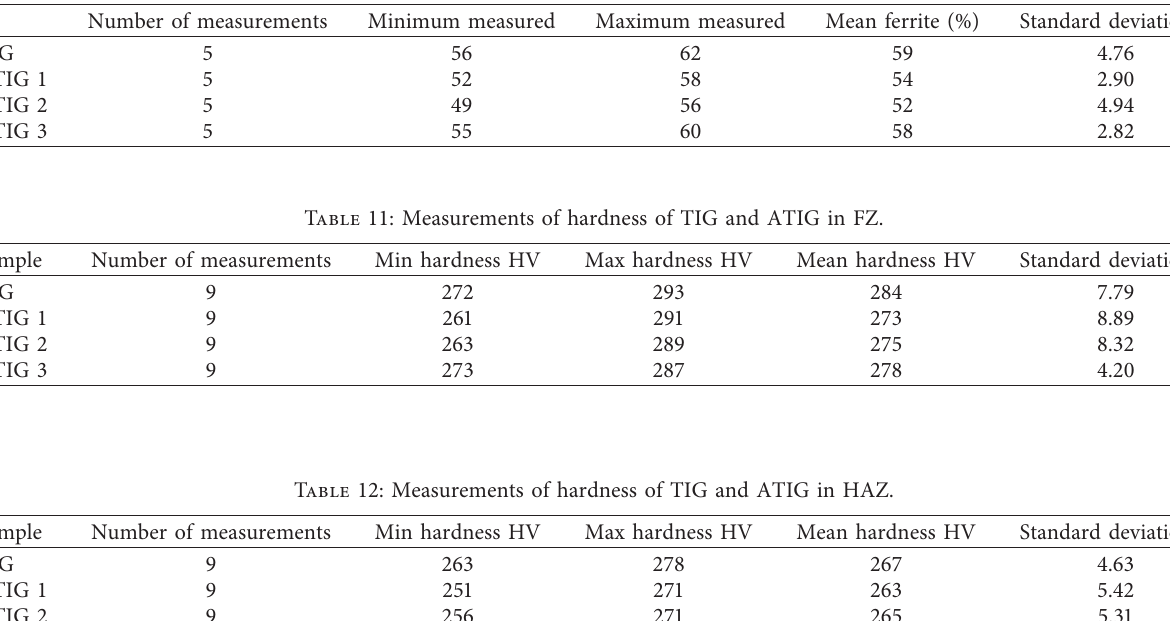
Figure 7: Ferrite/austenite proportions measurements for TIG and ATIG welds (SEM magnification 200 × ). (a) TIG weld zone (200 × ). (b) ATIG 1 weld zone (200 × ). (c) ATIG 2 weld zone (200 × ). (d) ATIG 3 weld zone (200 × ). Table 10: Ferrite volume fraction measurement.